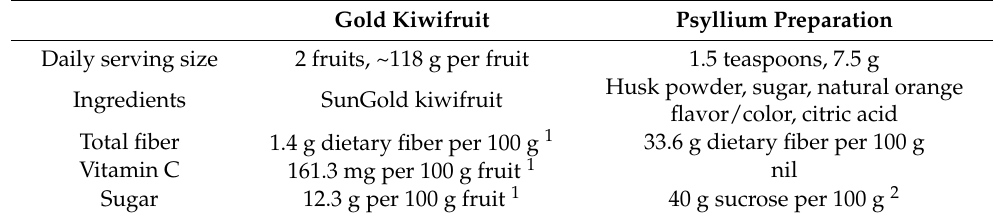
Table 1. Intervention composition summary.